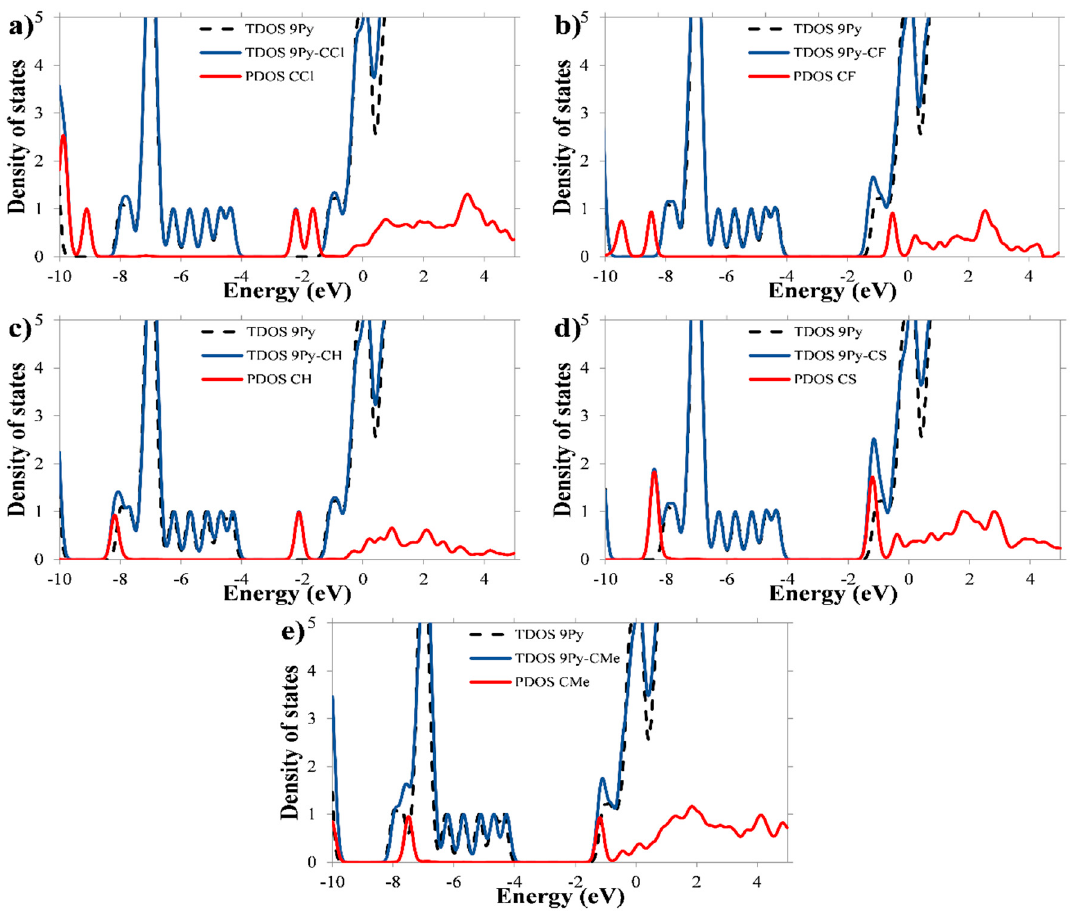
Figure 4. The total density of states (TDOS) for 9Py–HC complexes (solid blue line), projected density of states (PDOS) for the HC gases (red line), and TDOS for the isolated 9Py (dashed black line): ( a ) 9Py-CCl, ( b ) 9Py-CF, ( c ) 9Py-CH, ( d ) 9Py-CS, and ( e ) 9Py-CMe.